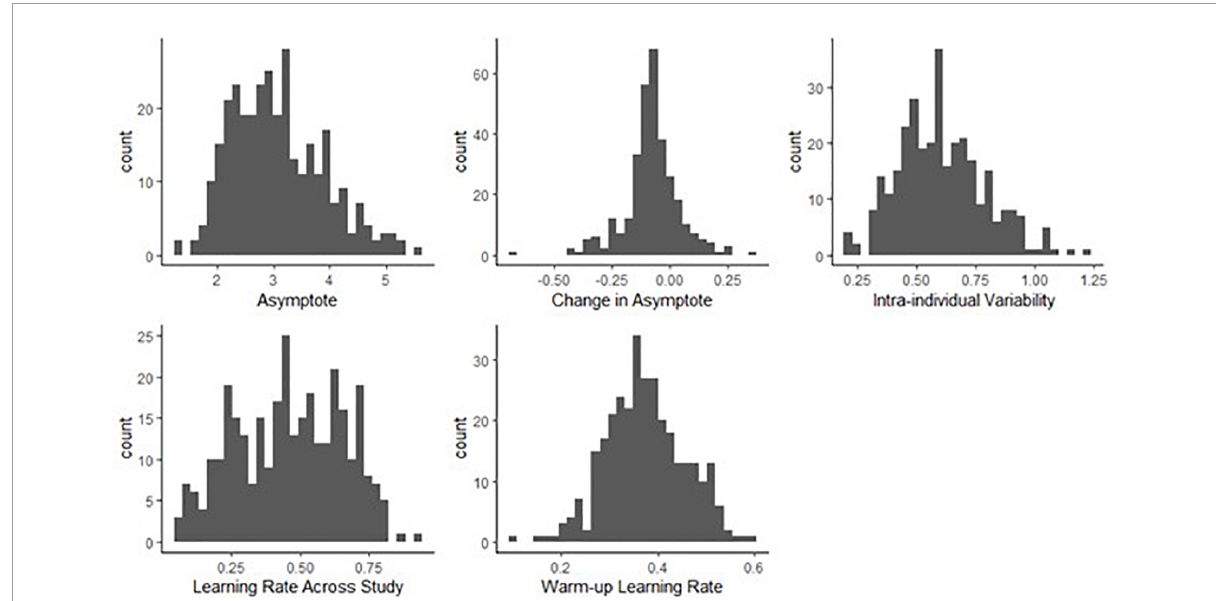
FIGURE8 Histograms of person-specific estimates for key BDEM parameters based on data from the symbol search task. The horizontal axis shows the (binned) parameter values while the vertical axis displays the frequency of occurrence of that value among participants.